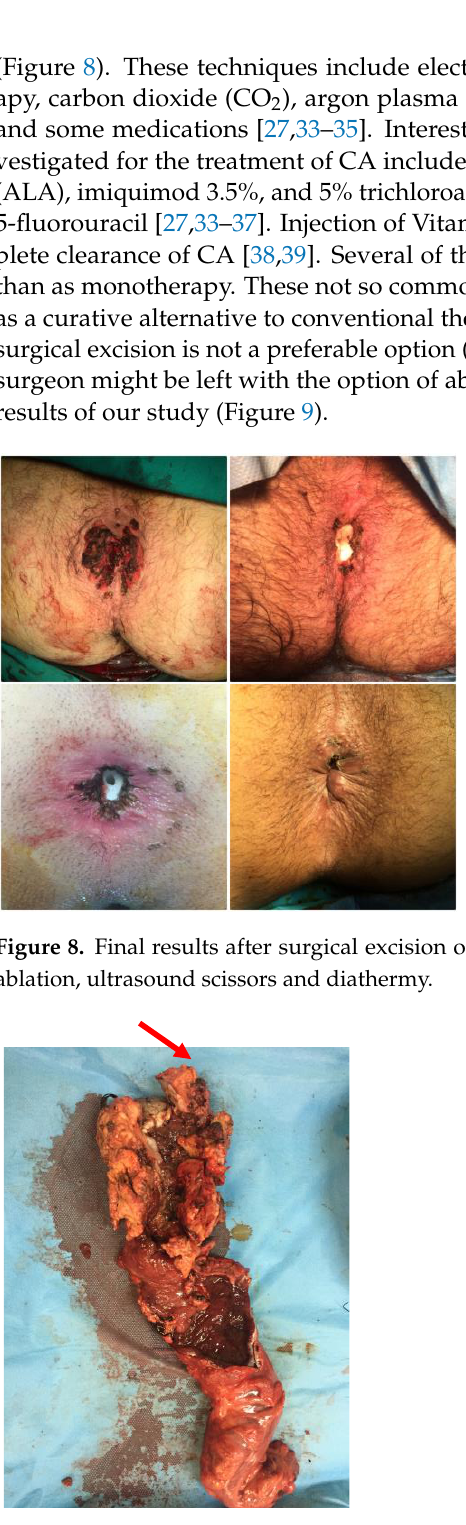
Figure 9. Specimen of abdominoperineal resection showing malignant transformation after local recurrence.